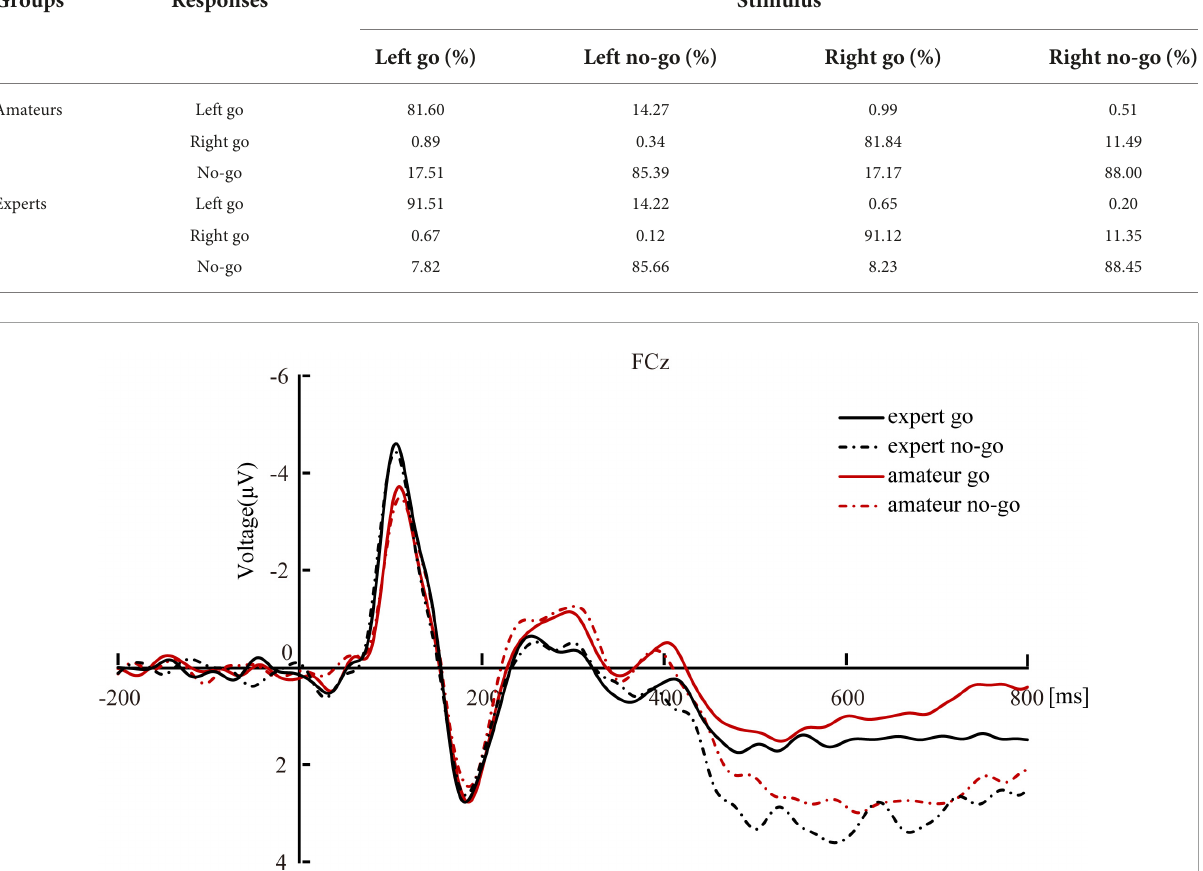
FIGURE2 N1 and P2 mean amplitudes to the go and no-go trials for LOL experts and amateurs. The zero on the x-axis indicates the onset of stimulus. The electrodes selected were